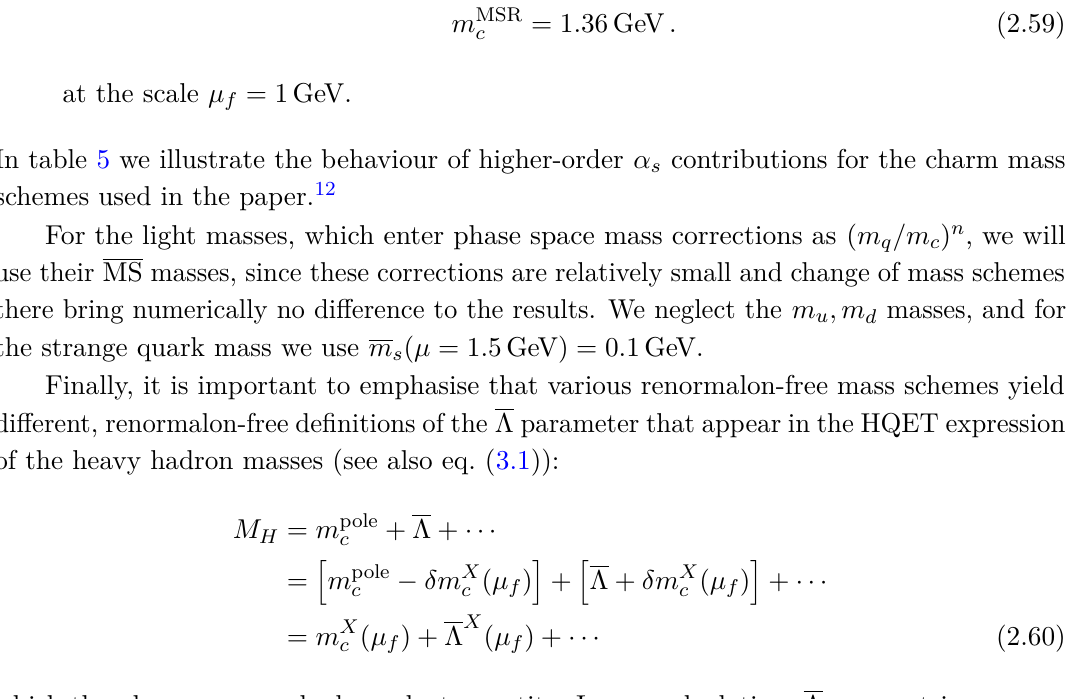
Table 5. Illustration of convergences of the charm quark masses for different mass schemes, expressed in units of GeV. In all cases the masses are expanded around the MS mass m 1 . 28 GeV [104, 105]. The scale µ µ f = 1 GeV for the MSR mass, with the values taken from [90]. The numerical values for m pole m kin